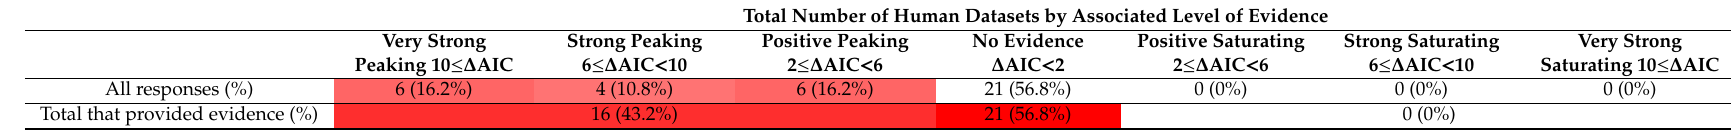
Table 2. Number of datasets for each level of evidence, for human only